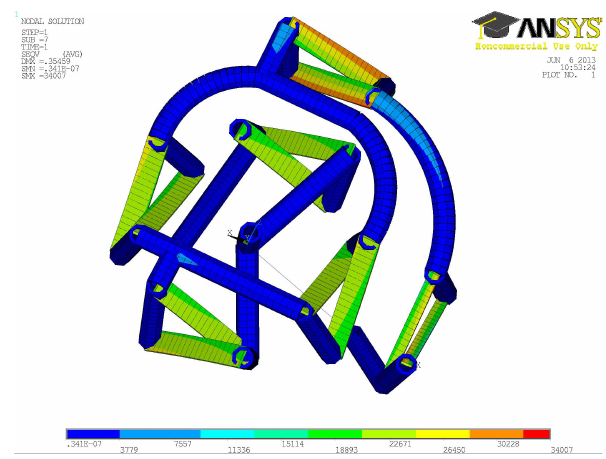
Figure 5. FEA representation of the mechanism at a deflected po- sition. Contours are Von Mises stress in lbsin − 2